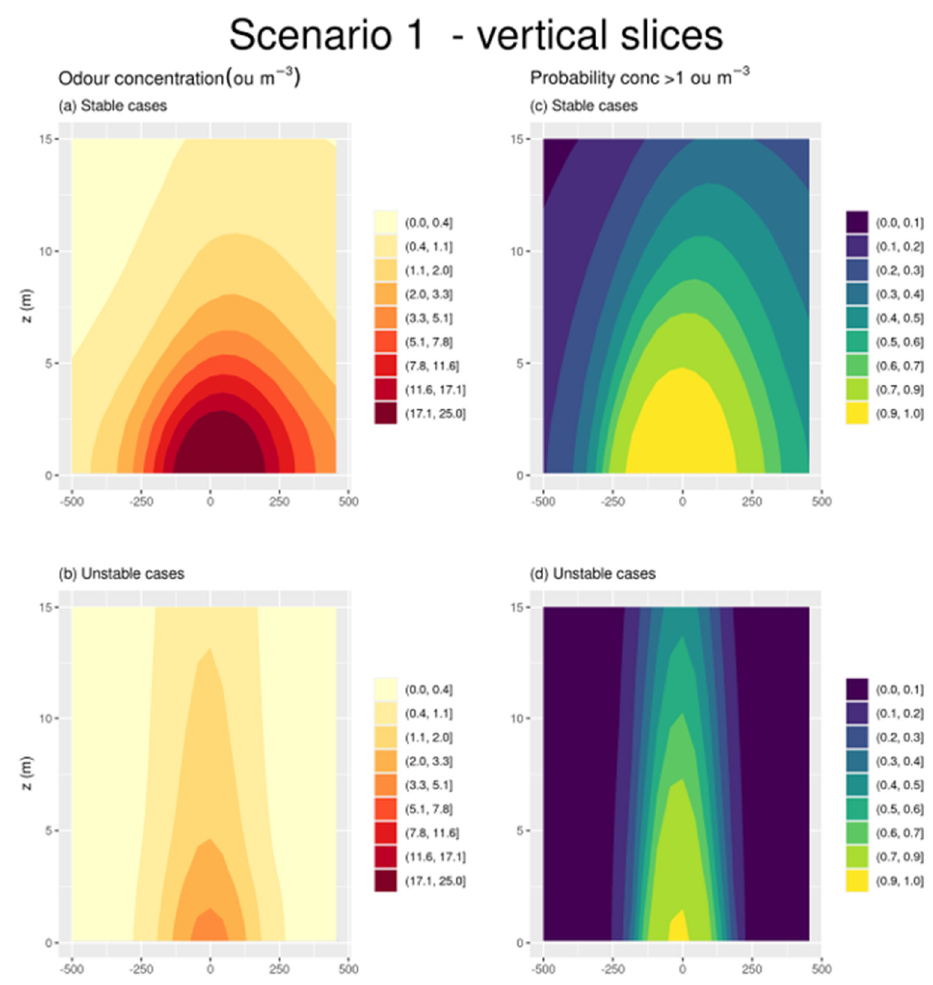
Figure 9. Vertical slices of the odour concentrations (left panel) and exceedance probability of the 1 ou m − 3 threshold (right panel) for an East–West transect placed at the latitude of the source’s center, as simulated by SCICHEM for the period 1 October 2020–31 October 2020, for scenario 1. Modeled concentrations and probabilities are represented for the stable ( a , c ), and unstable cases ( b , d ). The square in the center represents the fertilized field (emission source), and the x and y coordinates are expressed as the distances in meters from the center of the source.